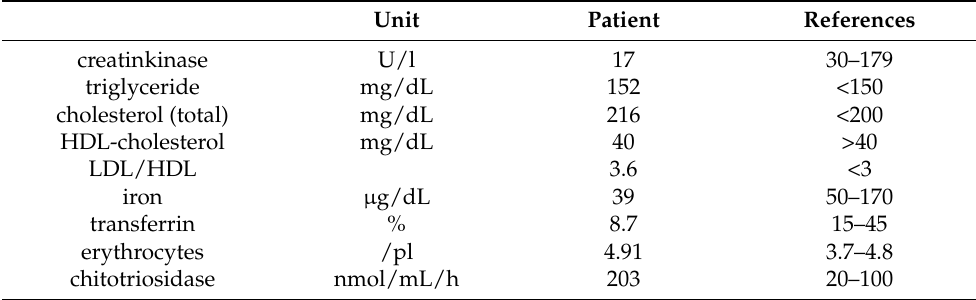
Table 1. Clinical findings at the point in time of the diagnosis of